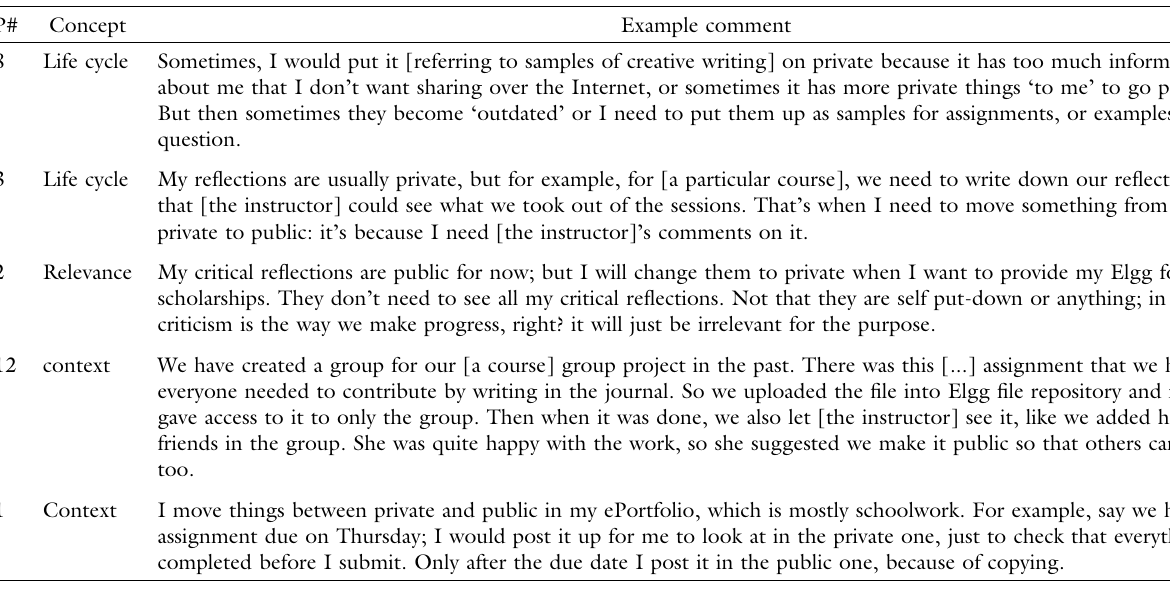
Table 3. Sample user quotes on privacy needs.